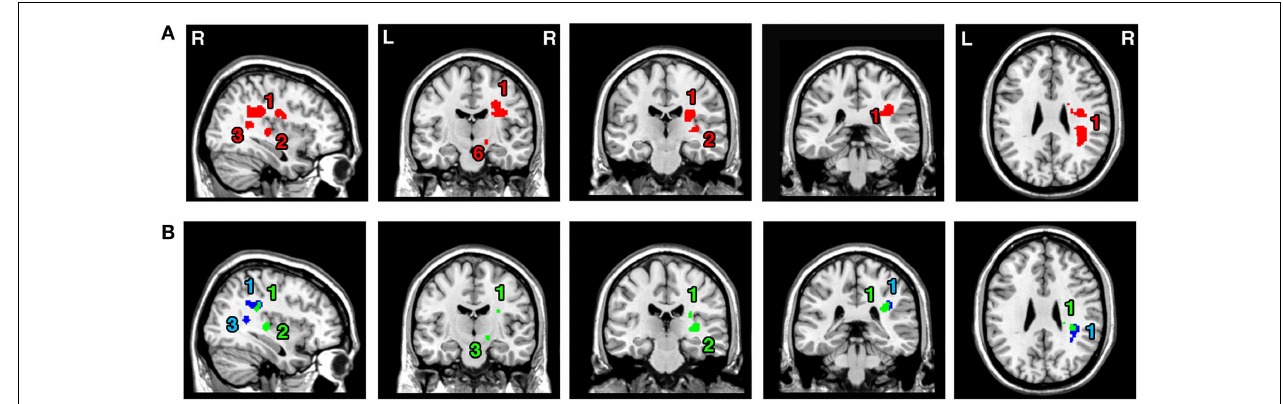
neglect syndrome ( Analysis 6 ). (B) The concurrence in white matter lesions associated with impaired control of attention either across space, i.e., egocentric frame of reference ( Analysis 7 ; green) or within objects, i.e., allocentric frame of reference ( Analysis 8 ; blue).The numbers denote indentified ALE clusters as listed in Table 4